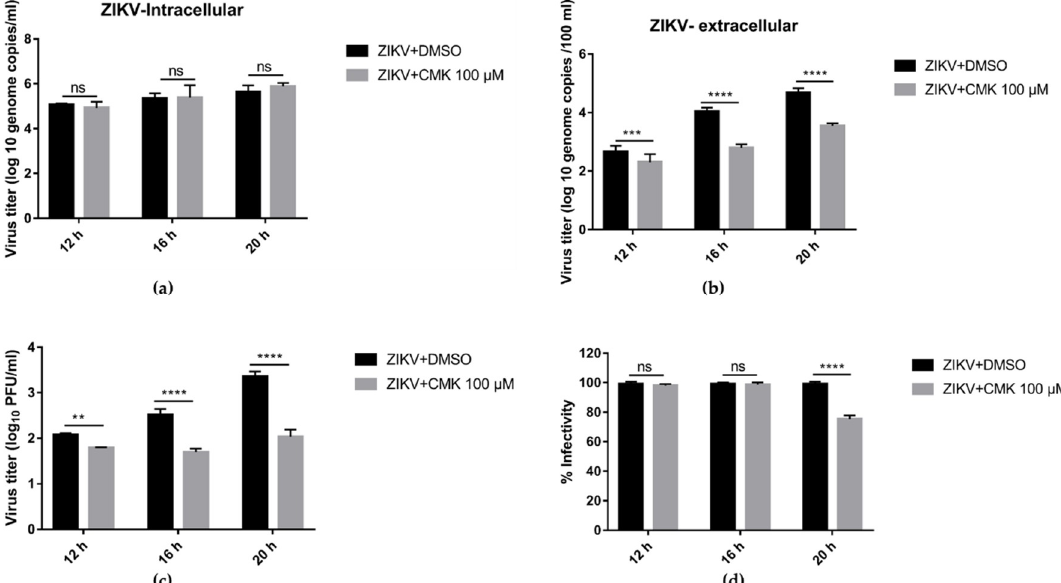
Figure 7. Dec-RVKR-cmk inhibits ZIKV release and next round infectivity. Vero cells were infected with ZIKV (1 MOI) followed by dec-RVKR-cmk treatment using the 100 µM concentration. ( a ) Infected cells were analyzed by qRT-PCR for absolute genome copies using the standard curve of in vitro transcribed ZIKV for the indicated time points. Cell supernatant was used to determine ZIKV viral titer by ( b ) qRT-PCR and also by ( c ) plaque assay. ( d ) The percentage infectivity was calculated by dividing the viral titer determined by plaque assay by the viral titer determined by qRT-PCR in supernatant, for both the control and treated groups, and then the value of the control group was normalized to 100 and compared with the treated group. Data are presented as the mean ± SEM from three independent experiments.